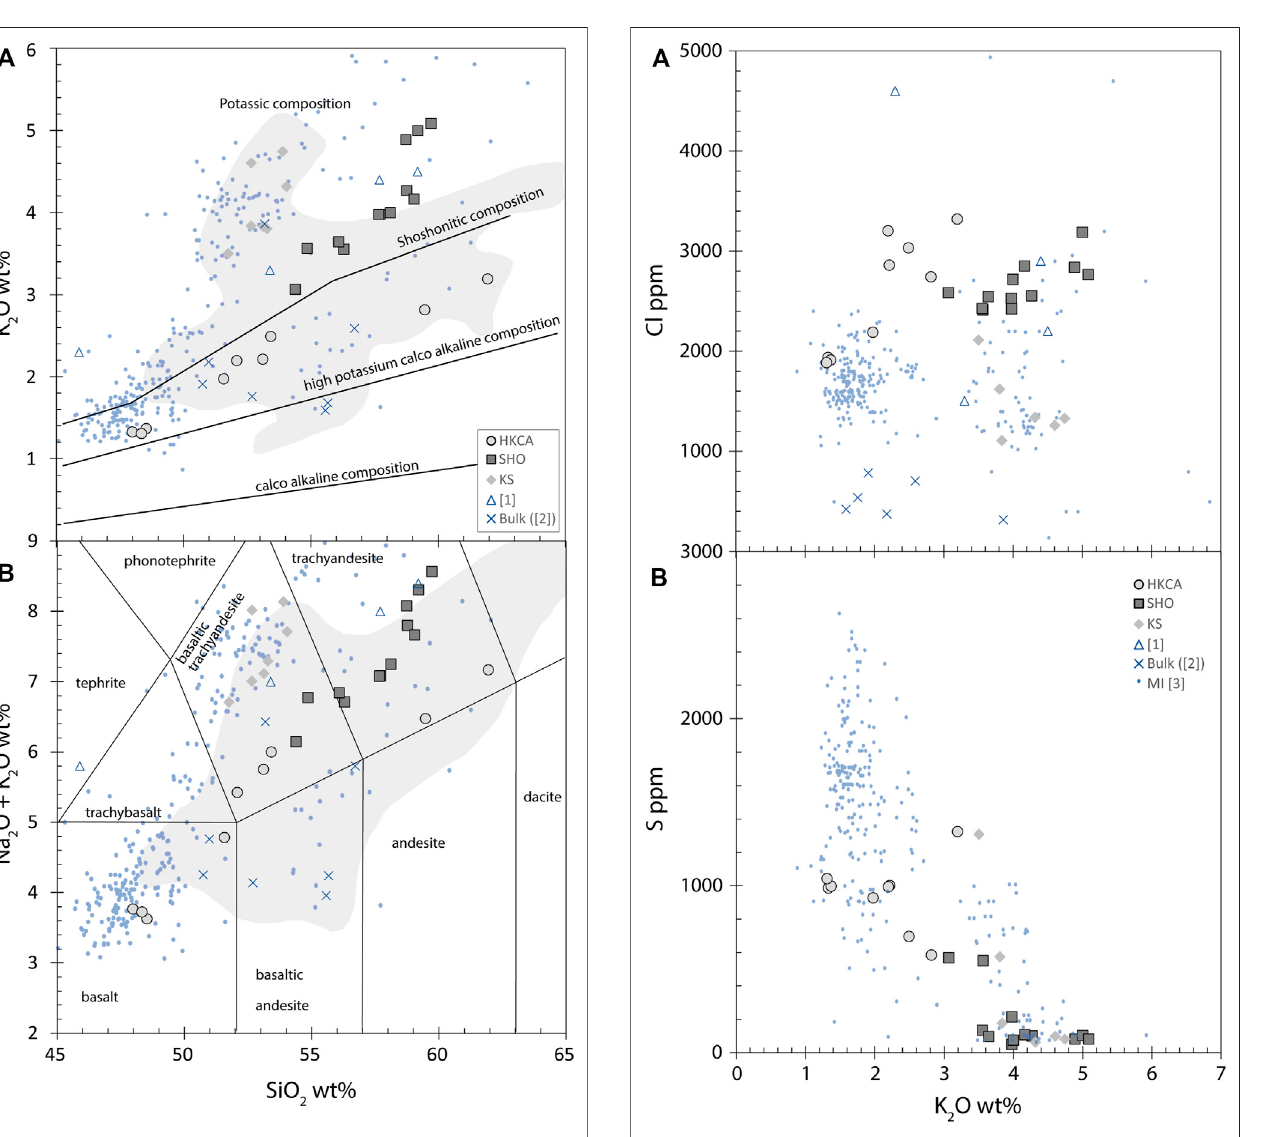
FIGURE 5 | (A) Chlorineand (B) sulfur contentscompared toK 2 Owt%in ST2 melt inclusions. Symbols are the same as in Figure 4 . (A) No relationship betweenClandK 2 Oisobserved.PotassicmeltinclusionshavelowerClcontent thanshoshoniticandhighpotassiumcalcoalkalineones.Allmeltinclusions have higher Cl content than bulk rocks. (B) High potassium calco alkaline melt inclusions have higher S content than shoshonitic and potassic melt inclusions, which have lost S due to degassing. High potassium calco alkaline melt inclusionshavemoderateScontentcomparedtoStrombolimeltinclusionsfrom the literature, having up to 2,600 μ g/g